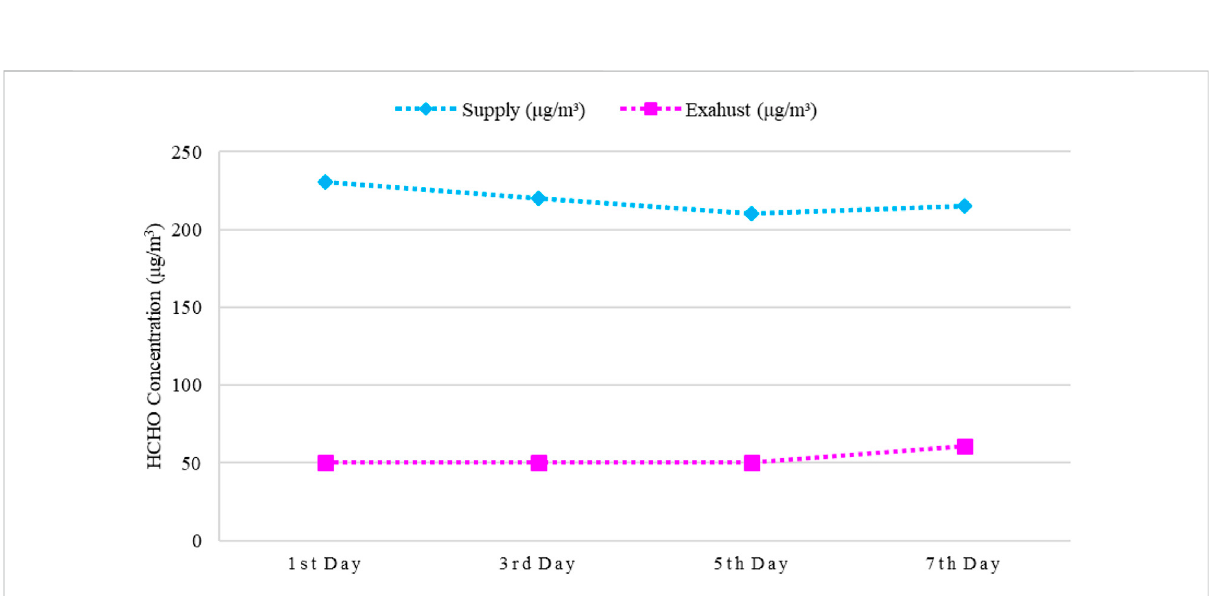
FIGURE 7 HCHO Adsorption Test Result (Normal wallpaper with 15